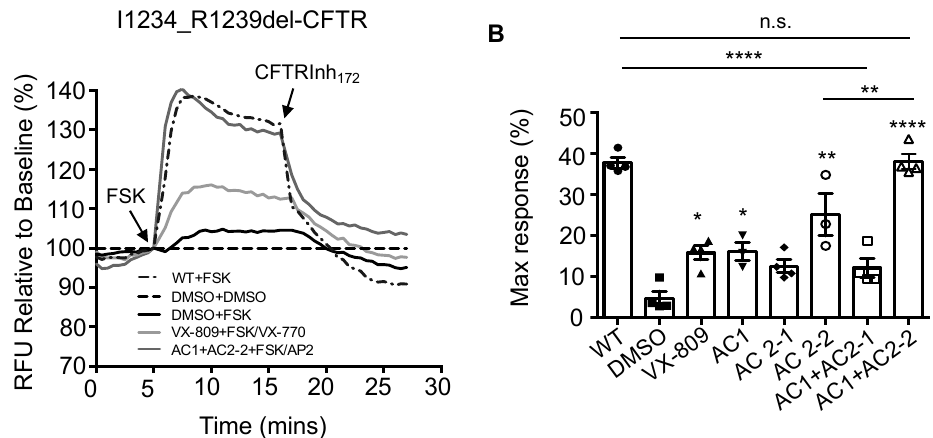
Figure 1. Novel triple combination of CFTR modulators completely rescue the functional expression of I1234_R1239del-CFTR in HEK293 cells. ( A ) Representative traces of I1234_R1239del-CFTR-dependent chloride e ffl ux using the imaging plate reader membrane depolarization assay (FLIPR). HEK293 cells were pre-treated with (DMSO), 3 µ M VX-809, 0.5 µ M AC1 + 3 µ M AC2-1, 0.5 µ M AC1 + 3 µ M AC2-2 for 24 h at 37 ◦ C. Following 5 min baseline measurement, 10 µ M FSK +/ − 1 µ M VX-770 or 1.5 µ M AP2 were added. After approximately 10 min incubation, CFTR inhibitor (CFTRinh-172, 10 µ M) was